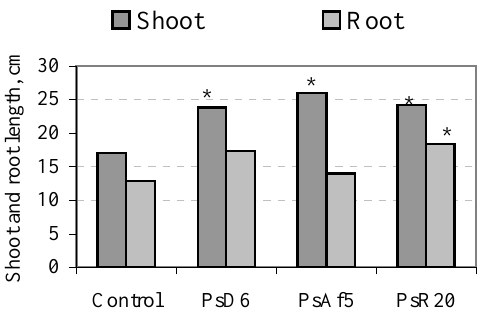
FIGURE 1 . Effect of Pseudomonas spp. on shoot and root growth of wheat, P. denitrificans PsD6, P. aureofaciens PsAf5, and P. rathonis PsR20. *Significant differences, p <